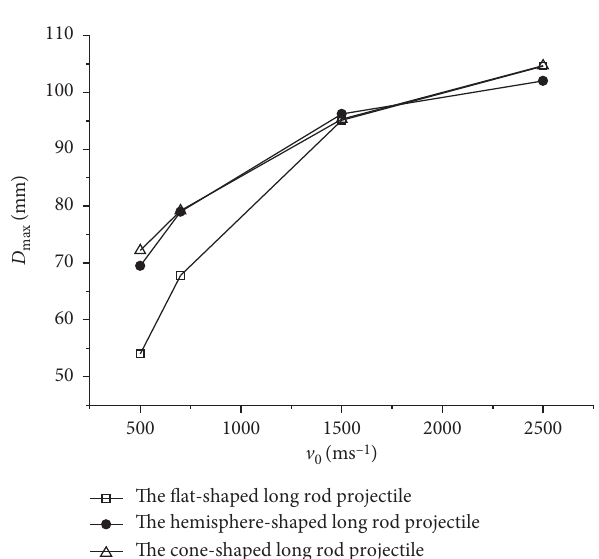
Figure 8: Penetration depth versus striking velocity of